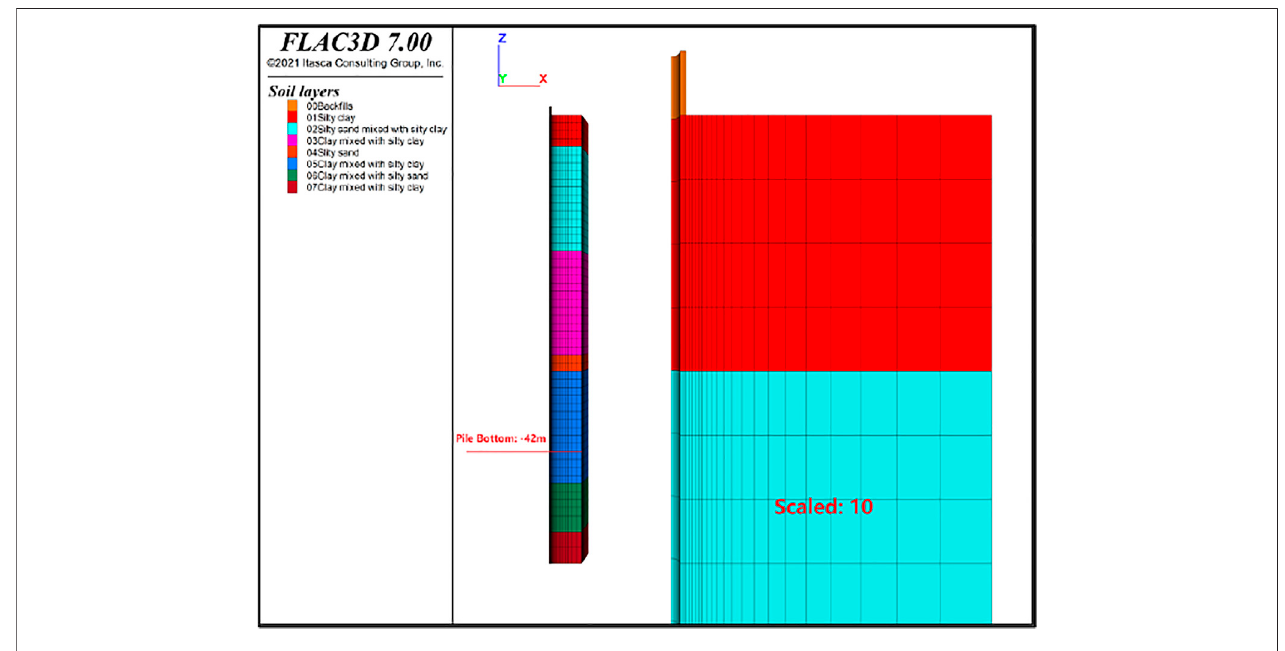
FIGURE 3 | Schematic description of the numerical model.